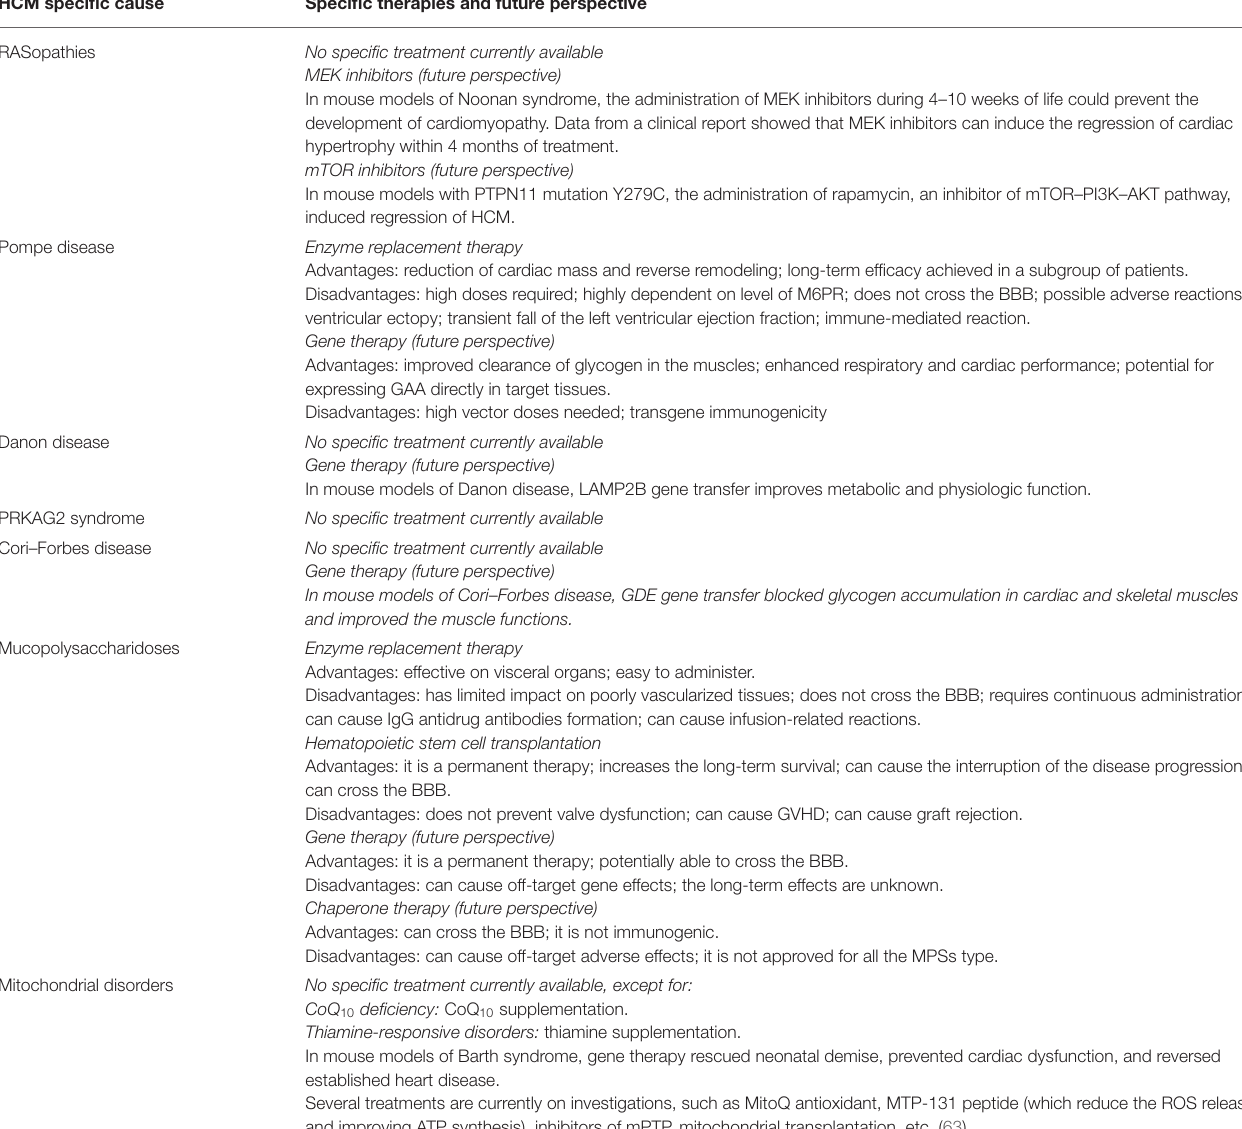
TABLE 3 | Advantages and disadvantages of the available treatments for Pompe